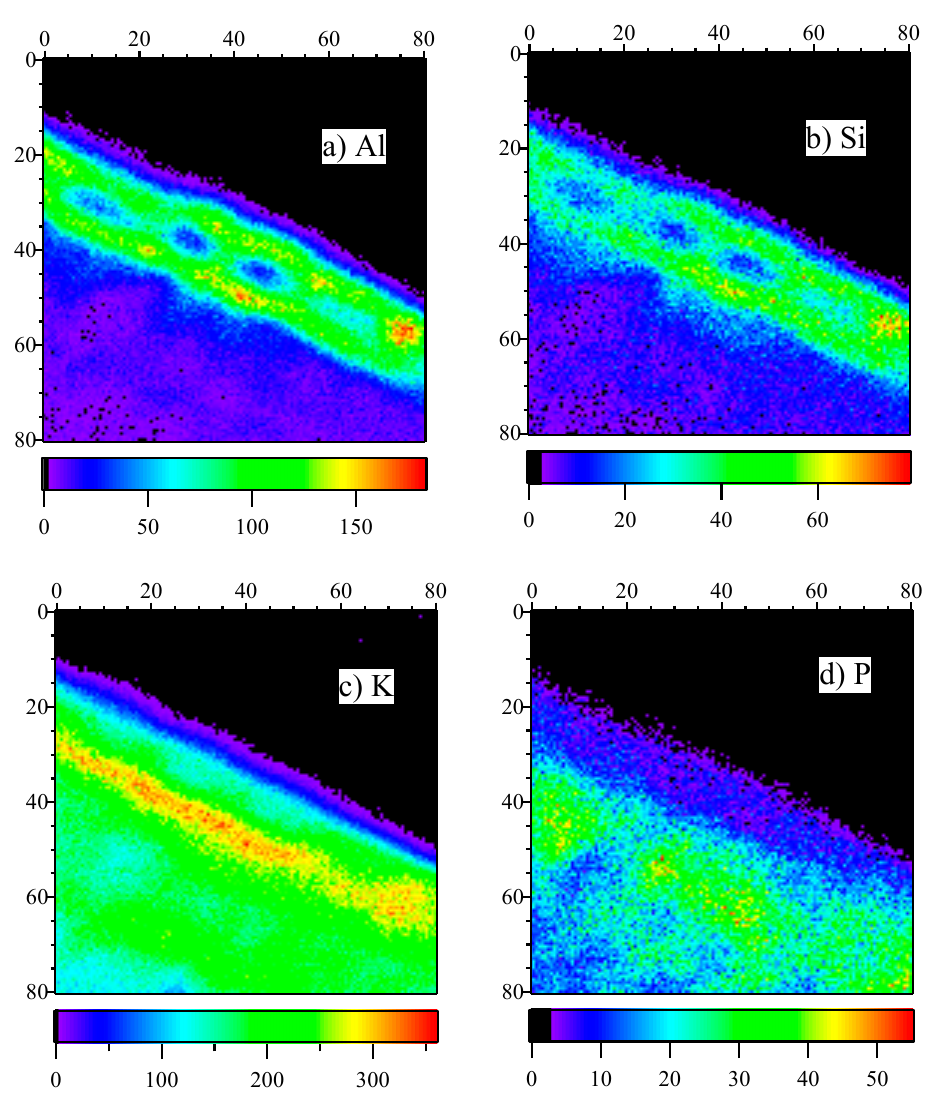
Figure 4. Close-up view of ( a ) Al, ( b ) Si, ( c ) K, and ( d ) P maps. Both axes indicate position in µ m. The color bar represents counts per pixel. The top of each figure corresponds to the upper side of the leaf.